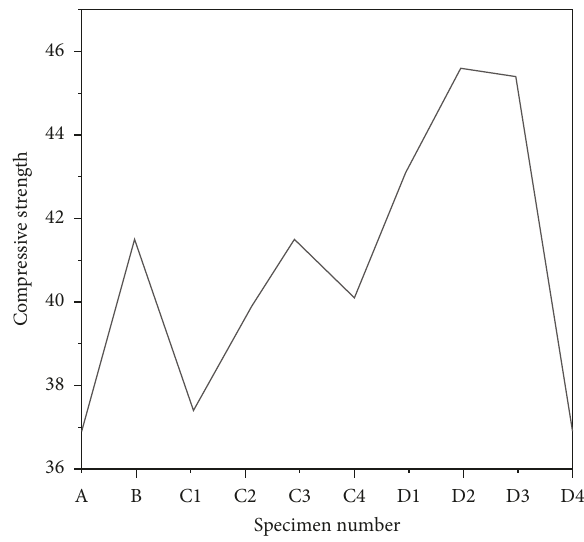
Figure 2: Compressive strength test results.